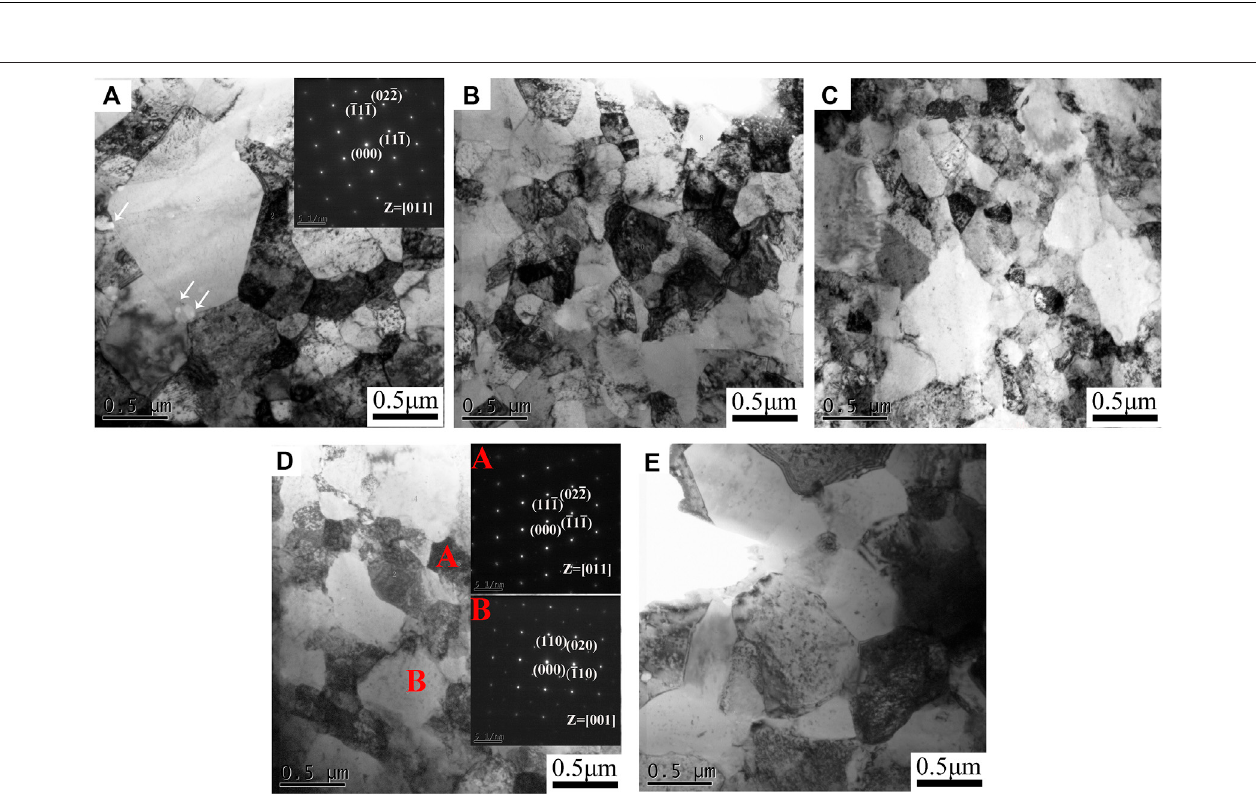
FIGURE5| TEMimagesofbright fi eldandcorrespondingSAEDpatternsofbulkFeCoNi(CuAl) x alloys(x (cid:1) 0,0.4,0.6,0.8,1.0): (A) x (cid:1) 0,inset:SAEDpatternofFCC matrix along [011] axis; (B) x (cid:1) 0.4; (C) x (cid:1) 0.6; (D) x (cid:1) 0.8, inset A: SAED pattern of grain A corresponding to a FCC structure along [011] axis; inset B: SAED pattern of grain B corresponding to a BCC structure along [001] axis; (e) x (cid:1) 1.0.